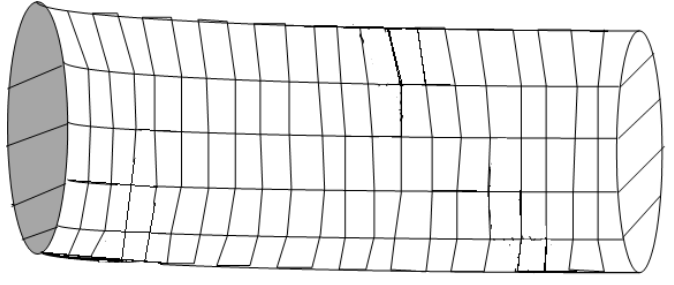
Figure1. Discrete geometric model of the